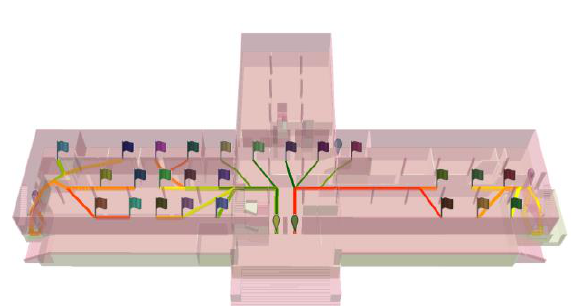
Figure 27. Obstruction Scenario in the Data Server Room